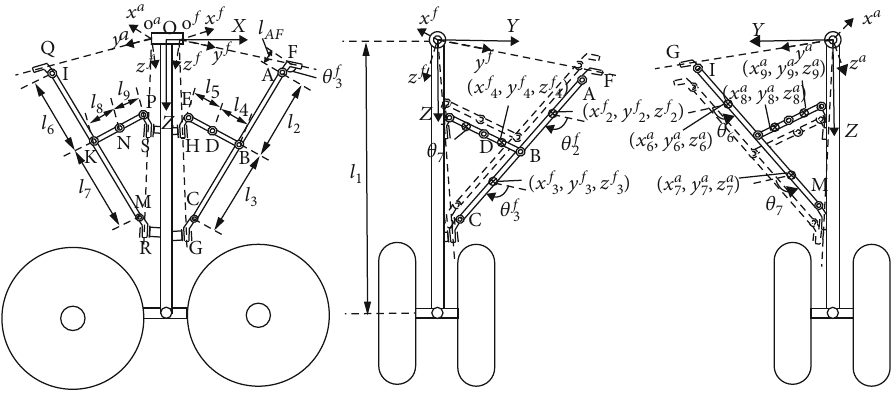
Figure 12: Schematic diagrams of the DS mechanism.